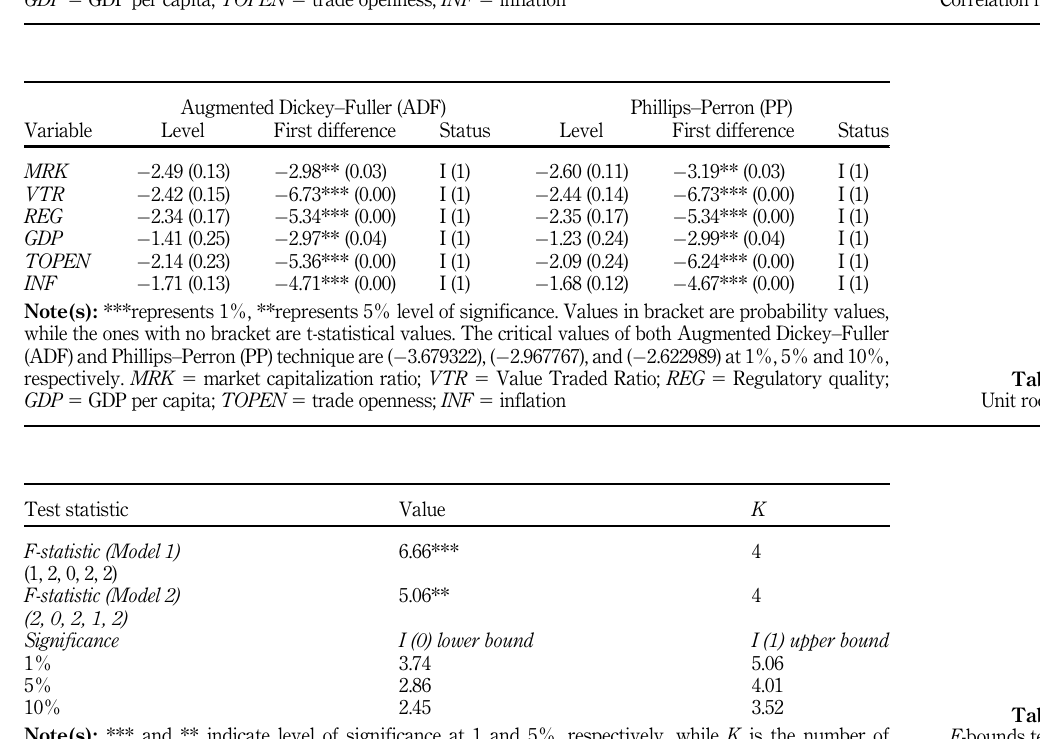
Table 7. F -bounds test